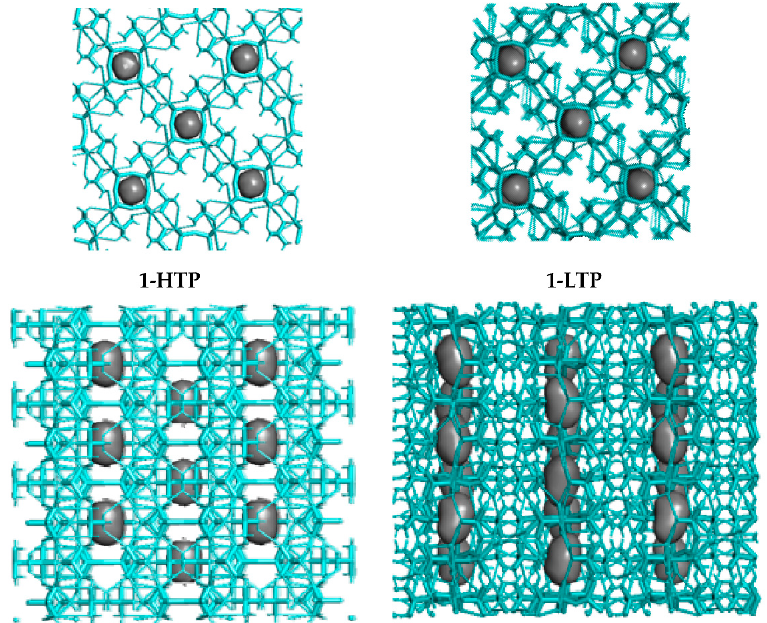
Figure 4. Crystal packing (top and side views of the holes) in compound 1-HTP at the left and compound 1-LTP at the right.